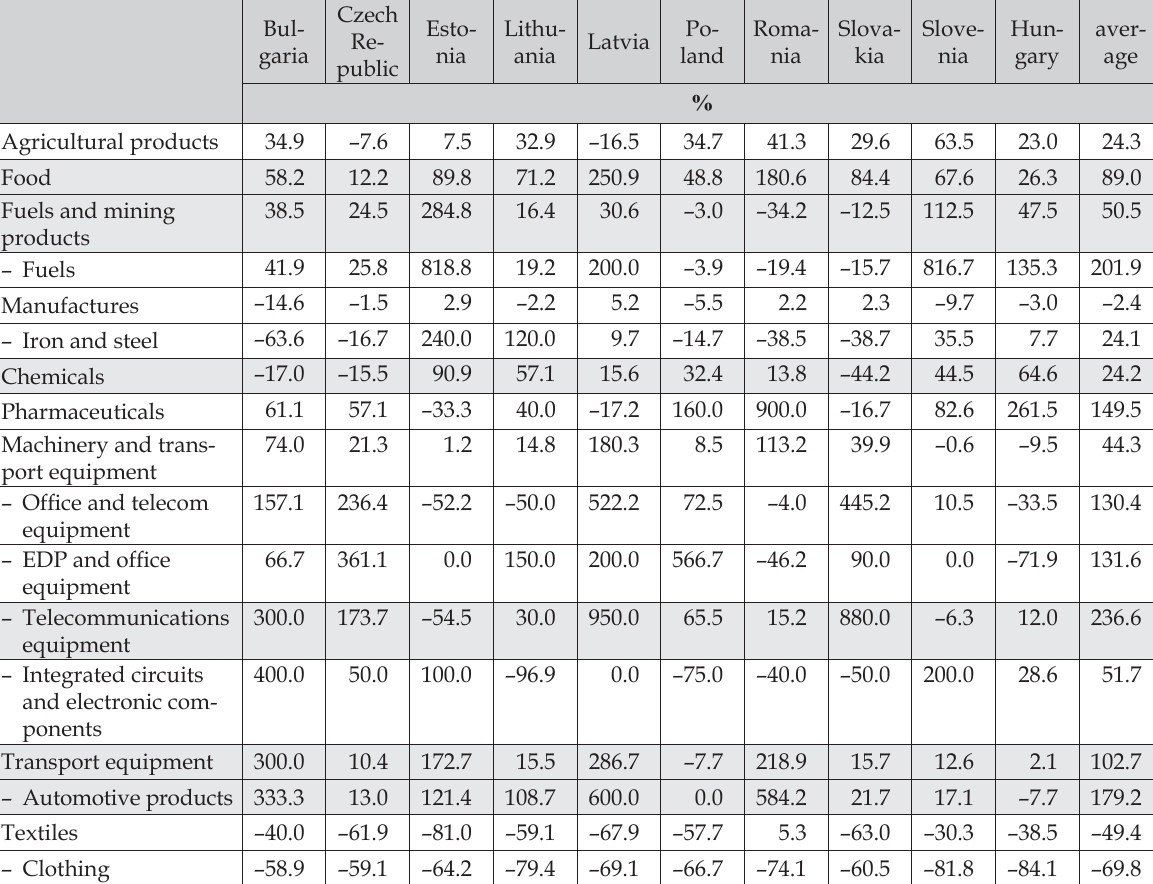
Table 3. Changes in the commodity structure of exports in the post-communist countries from 2000 to 2012.